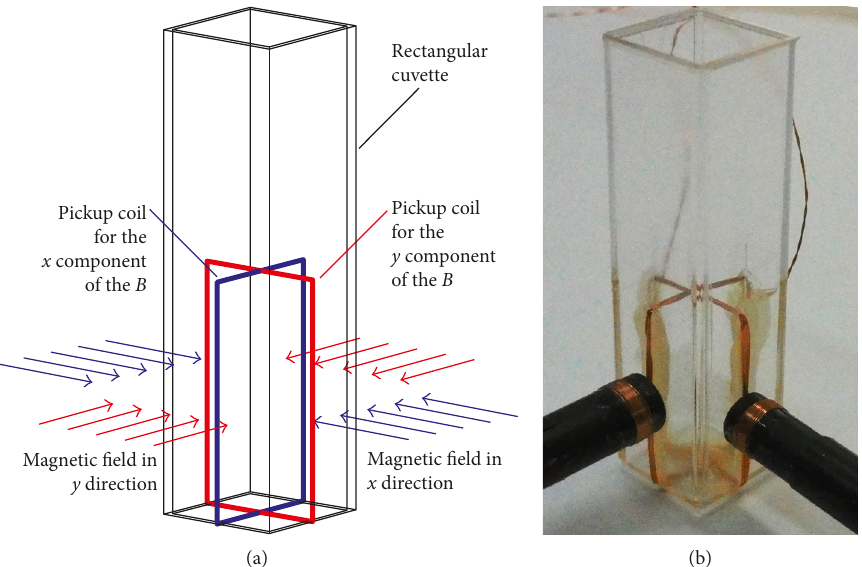
Figure 3: (a) Scheme for the sample cuvette adapted to contain a pair of orthogonal coils with 5 turns each for the x and y directions. (b) The actual picture of all four-measurement coils outside the